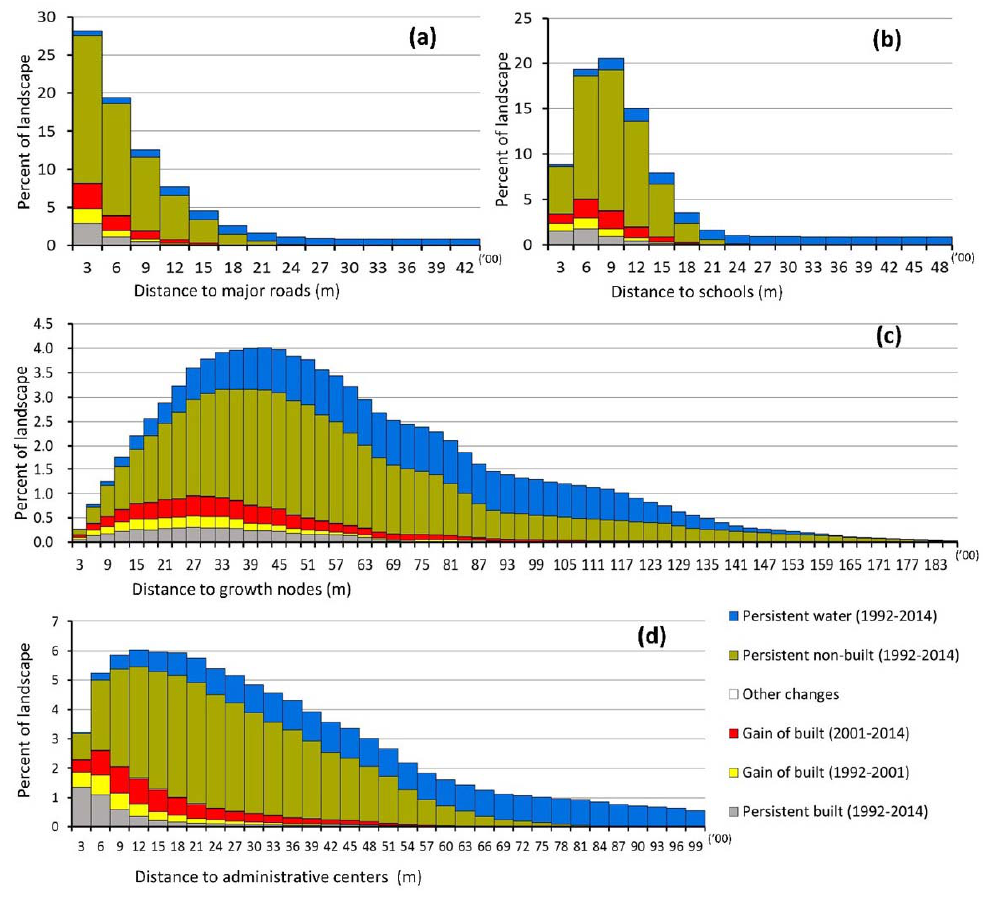
Figure 4. Observed ULCs along the gradients of the driver variables: ( a ) distance to major roads; ( b ) distance to schools; ( c ) distance to growth nodes; and ( d ) distance to administrative centers.